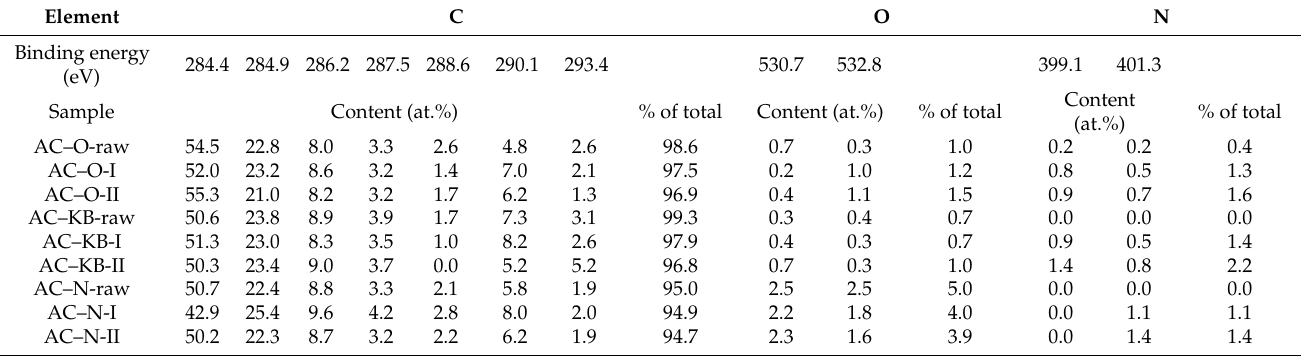
Table 4. The elemental composition of the obtained N-doped activated carbons from XPS